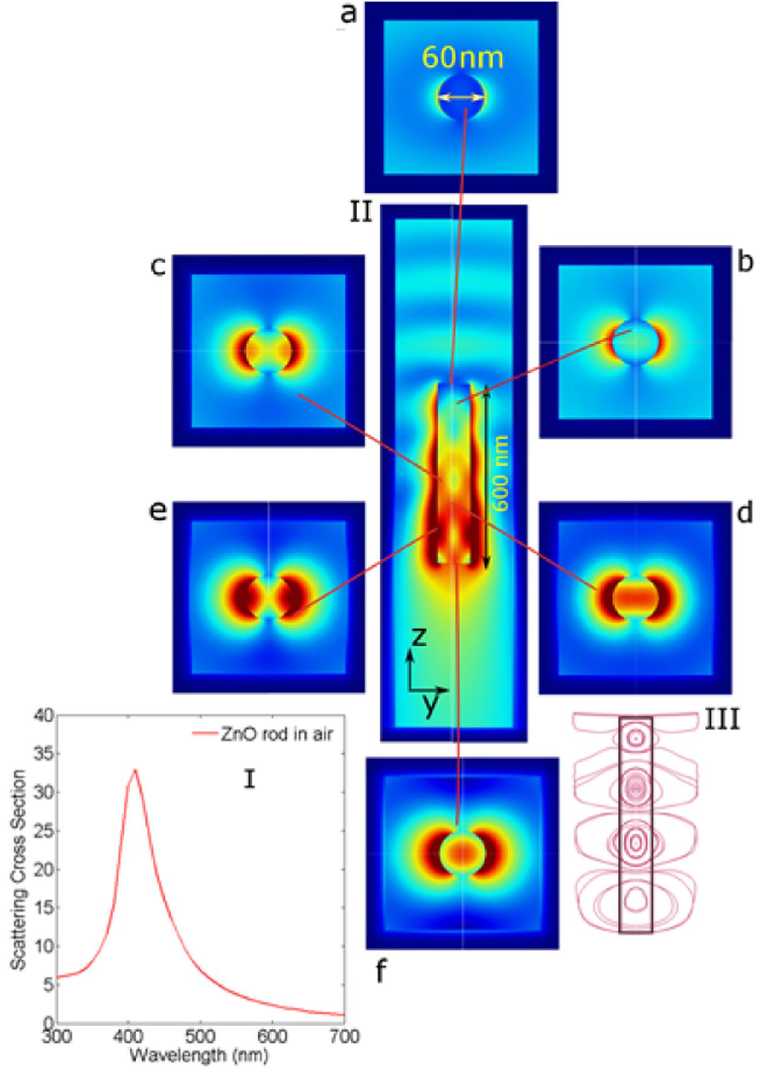
Figure 2. (I) Scattering cross section of a ZnO rod in air. (II) Longitudinal electric field plot of ZnO nanorod in air at the wavelength of 410 nm. ( a–f ) Transverse sections of the rod as light propagates along the rod length showing evolution of electric field inside the rod. (III) Streamline plot of the electric field indicating expansion of electric field as the light propagates along the